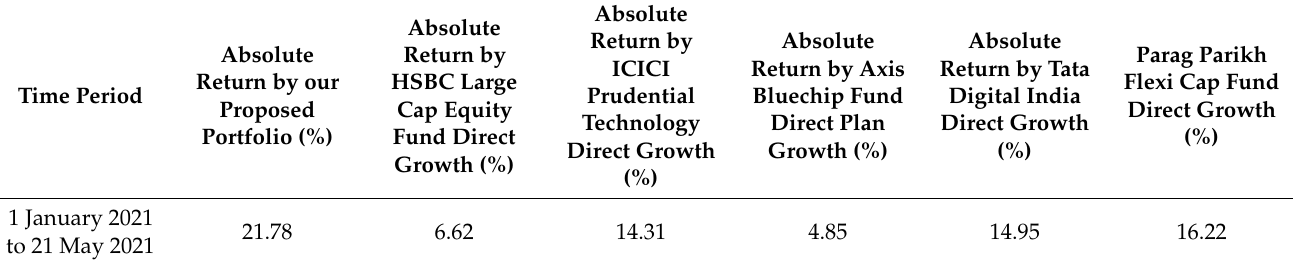
Table 6. Comparison of the performance of the proposed portfolio with popular mutual